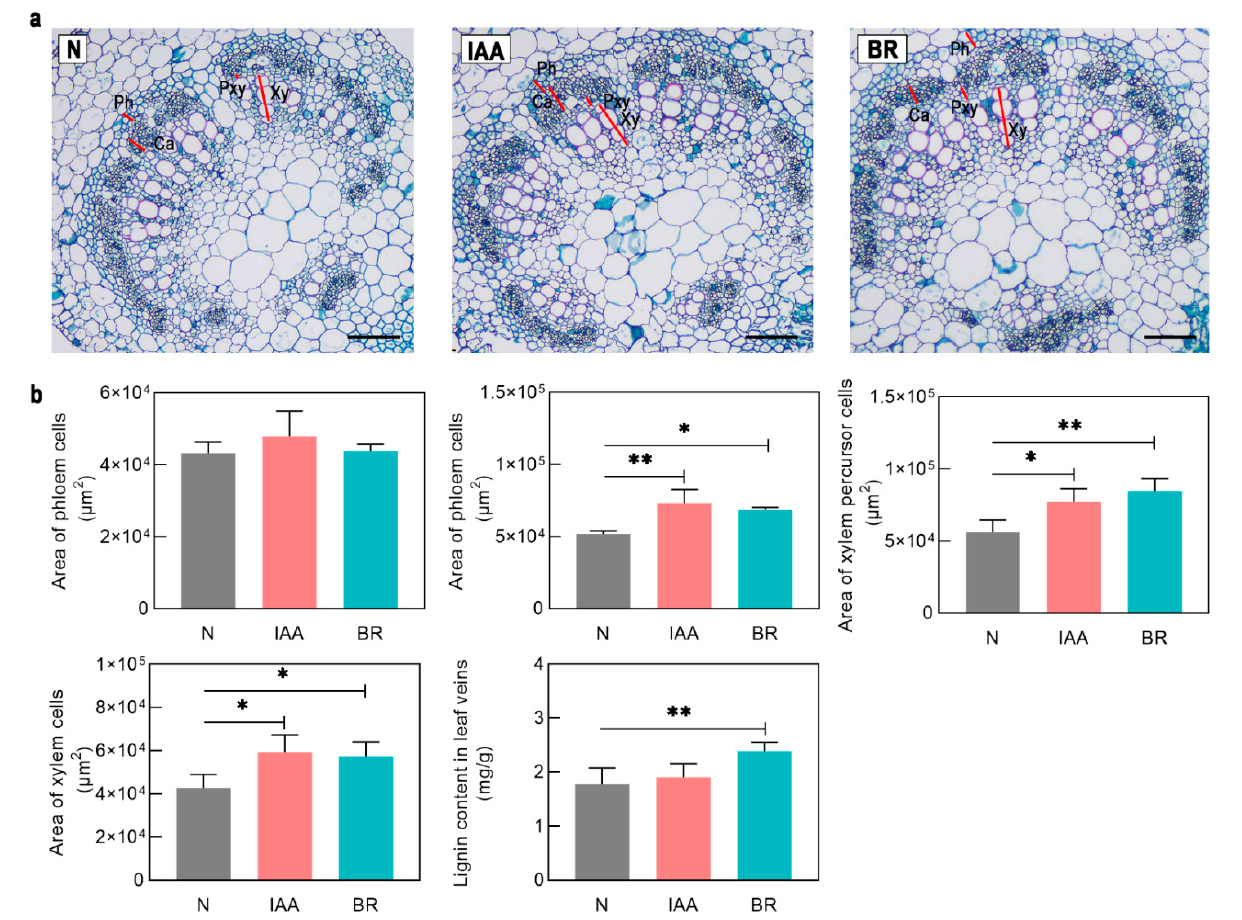
Figure 5. ( a ) The anatomy of the leaf veins. Ca, cambium cell; Ph, phloem cell; TE, tracheary cell; Pxy, xylem precursor cell. All black scale bars indicate 100 μ m. ( b ) Phenotypic analysis of soybean leaf veins under IAA and BR treatment. Asterisks indicate significant differences between controls and treatments (* p < 0.05, ** p < 0.01).